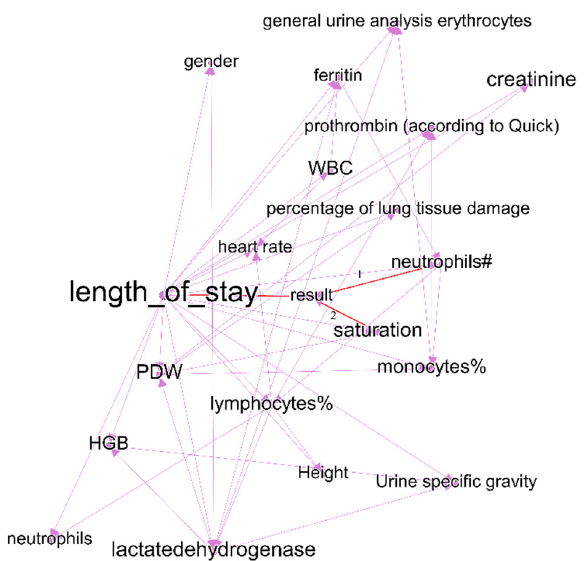
Figure 5. Cluster from DAG for the first-time interval, which includes the variable length of stay and treatment